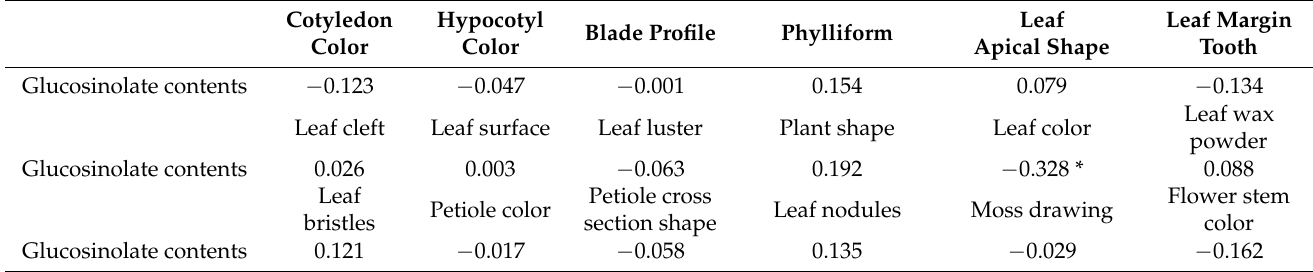
Table 6. Correlation between quantitative traits and glucosinolate contents in 60 mustard resources. Table 7. Correlation between quality traits and glucosinolate contents in 60 mustard